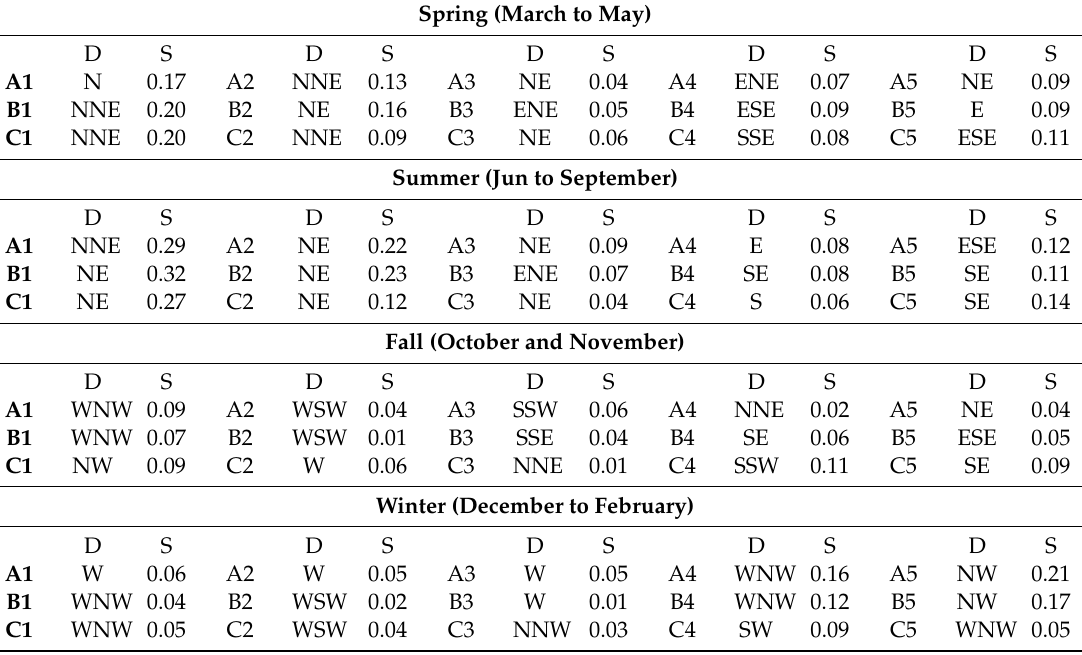
Table A2. Seasonal flow field data from the CODAR data (Figure 8). S represents the flow speed (m / s) and D represents the flow direction (sixteen